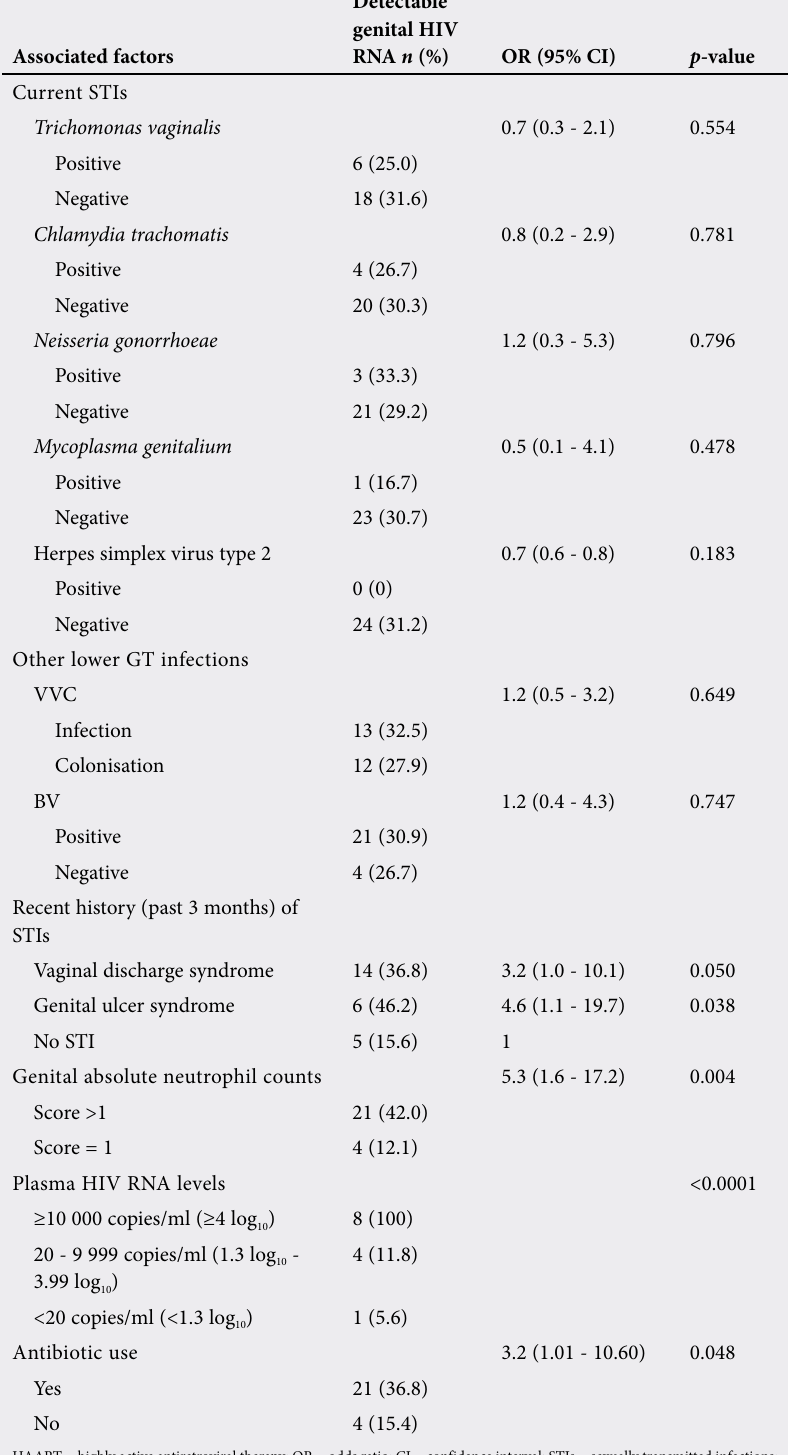
HAART = highly active antiretroviral therapy; OR = odds ratio; CI = confidence interval; STIs = sexually transmitted infections; GT = genital tract; VVC = vulvovaginal candidiasis; BV = bacterial